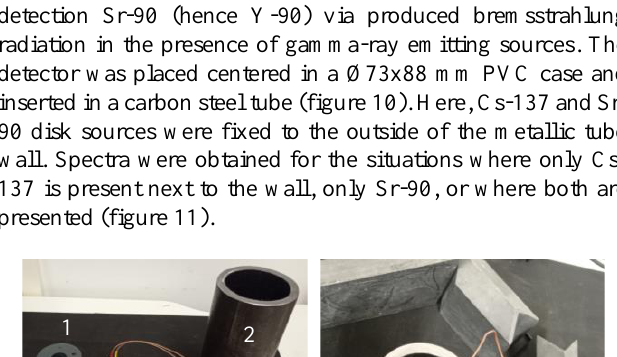
Figure 12 – Measured spectra of bremsstrahlung radiation and gamma-ray radiation of Sr-/Y-90 and Cs-137 respectively. The sources were placed in outer side of a 1cm wall carbon steel